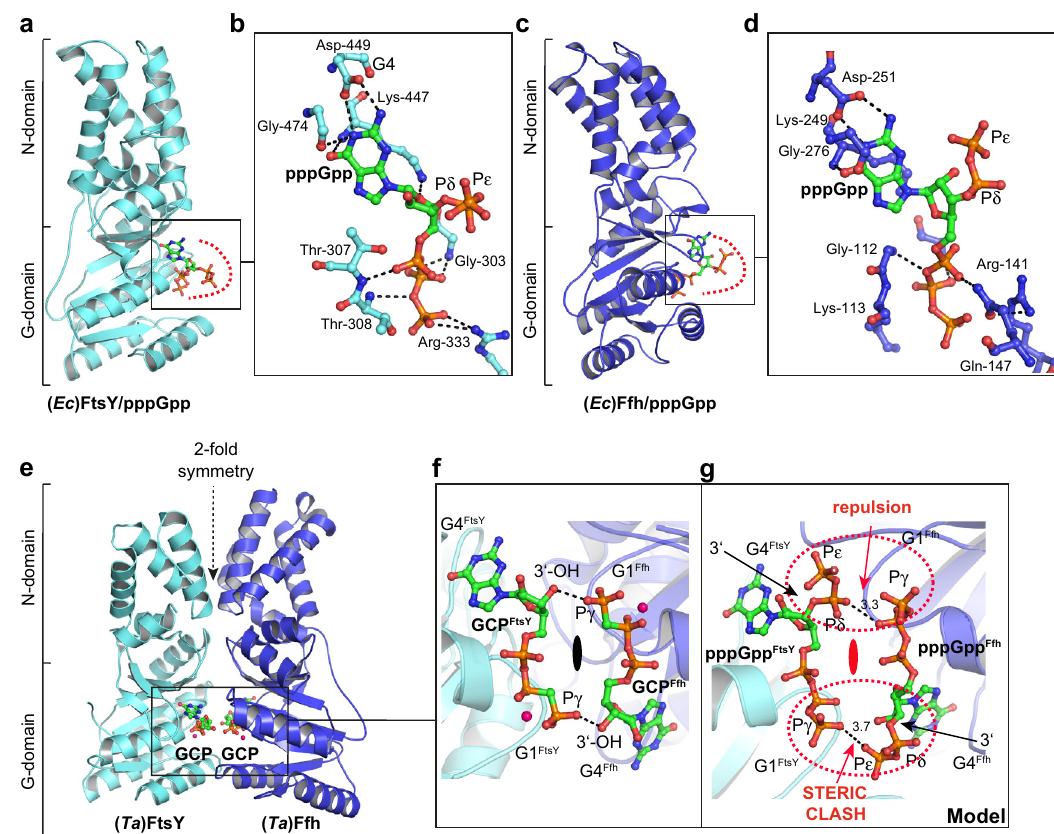
Fig. 4 (p)ppGpp binds in the nucleotide-binding pocket of the Ffh and FtsY-NG domains. a Overall topology of ( Ec )FtsY-NG in complex with pppGpp. b Zoom into the active site of ( Ec )FtsY-NG bound to pppGpp highlighting the residues involved in ligand binding. c Overall topology of ( Ec )Ffh-NG in complex with pppGpp. d Detailed view of the active site and the residues involved in binding of pppGpp. e Overall topology of the Ffh/FtsY-NG domain heterodimer from Thermus aquaticus (Ta) bound to two GCP (GppCp, a non-hydrolysable GTP-analog) molecules mimicking the binding of GTP in the twinned nucleotide-binding site (PDB-ID: 1OKK) 32 . f Zoom into the nucleotide-binding pocket shared between the NG domains of Ffh and FtsY. The 3 ’ -OH of one GCP molecule interacts with the γ -phosphate of the opposing GCP molecule and vice versa. g Overlay of the Ffh/FtsY heterodimer with the pppGpp-bound structures of ( Ec )Ffh and ( Ec )FtsY (this study). Close up of the shared nucleotide-binding site shows that the δ - and ε -phosphates at the 3 ′ -OH position of the ribose moiety of (p)ppGpp will lead to charge repulsion, where the hydrogen bond is formed in the heterodimer. Reciprocal arrangement of the two GTP nucleotides in the shared catalytic side of the Ffh/FtsY heterodimer would thereby be